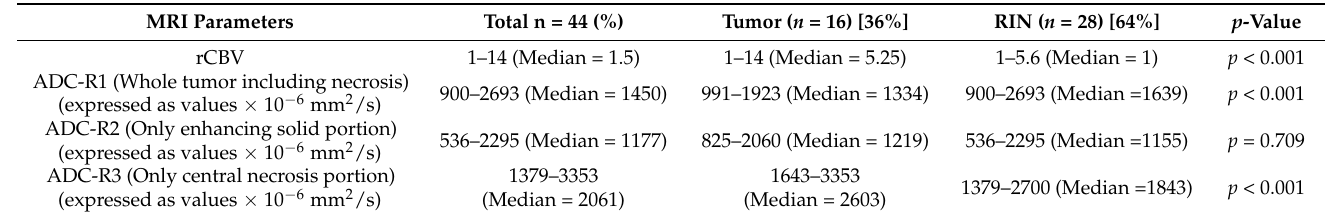
Table 1. Details of MRI findings on MR Imaging with new enhancing